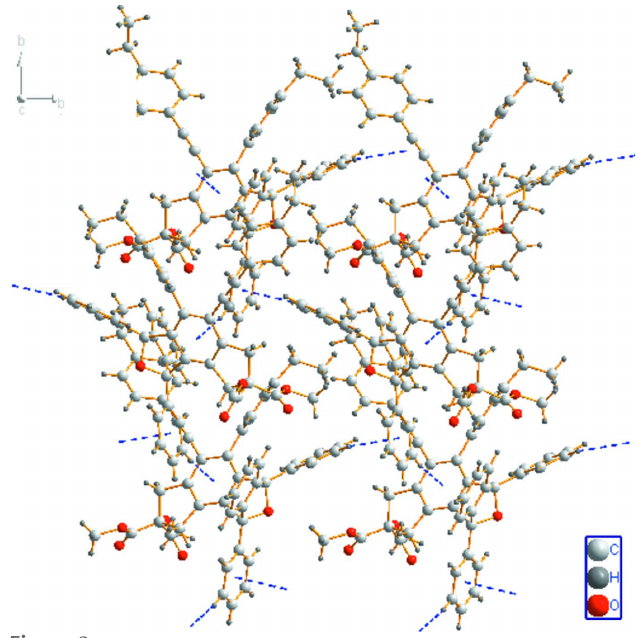
Figure 2 A packing diagram of the title compound, viewed along the c axis. The